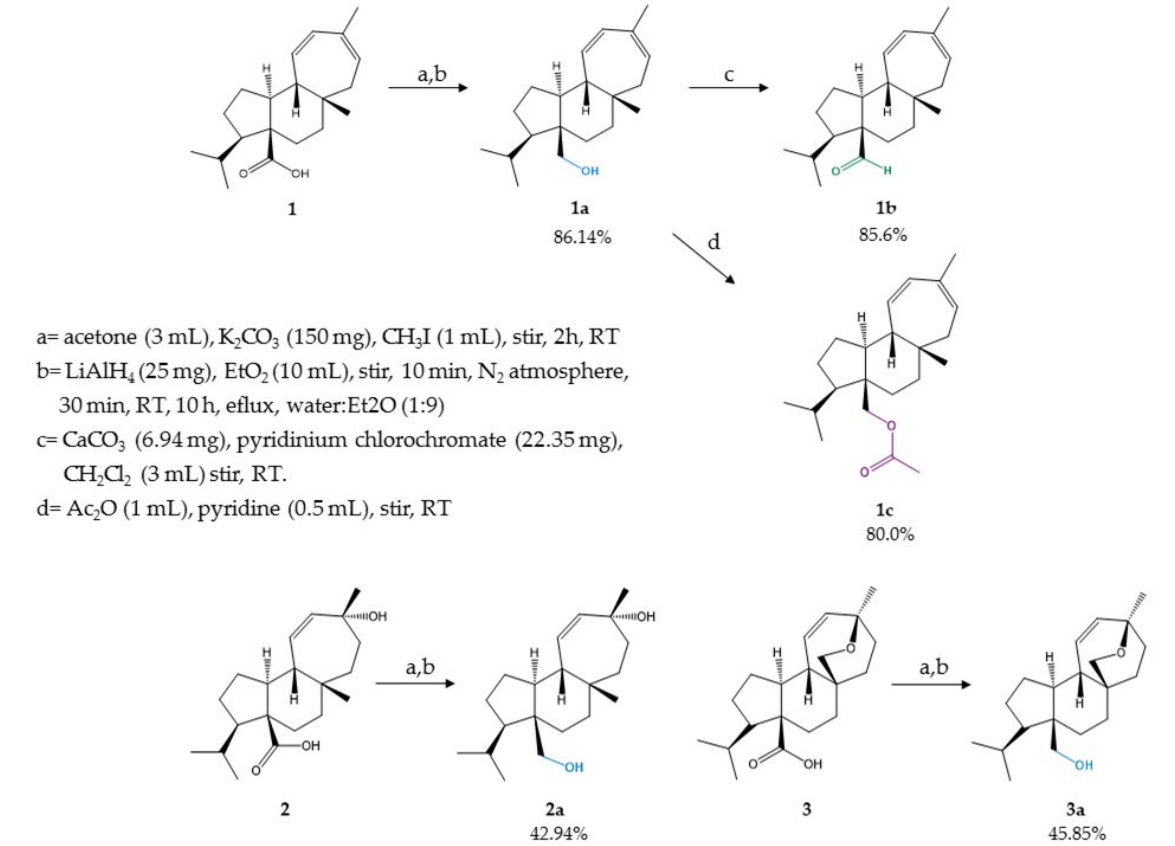
Figure 1. Preparation of semisynthetic derivatives from the natural mulinanes: mulin-11,13-dien-20-oic acid (1); mulin-11,13-dien-20-ol (1a); mulin-11,13-dien-20-al (1b); mulin-11,13-dien-20-yl acetate (1c); 13 α -hydroxymulin-11-en-20-oic acid (2); 13 α -hydroxymulin-11-en-20-ol (2a); mulinenic acid (3); mulinenol (3a).